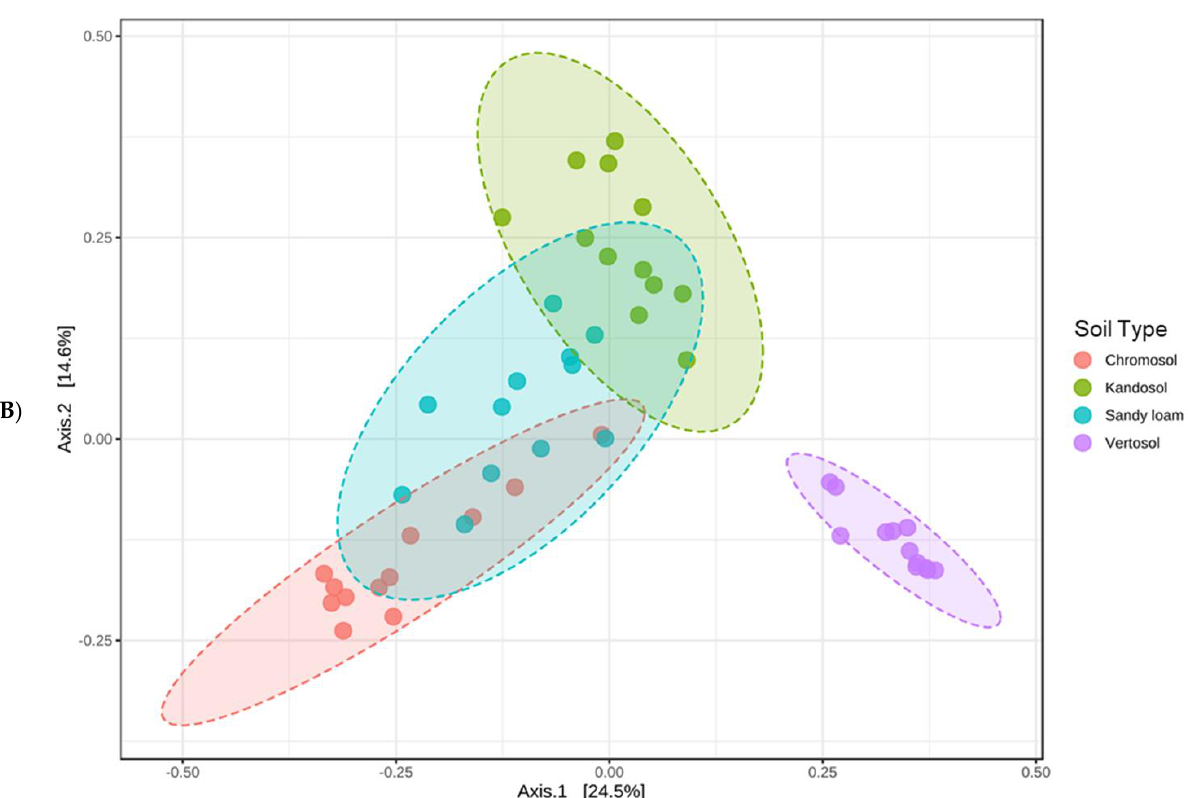
Figure 5. The soil fungal community assembly in the different soil types assessed in response to the control, dung, and dung plus beetle treatments. ( A ) The taxonomic distribution of fungal communities under different pasture management practices at the feature level. ( B ) Principal coordinate analysis of 16 s rRNA diversity in the rhizosphere of the different soils assessed (data from all treatment types combined due to similarity of the treatment effect).